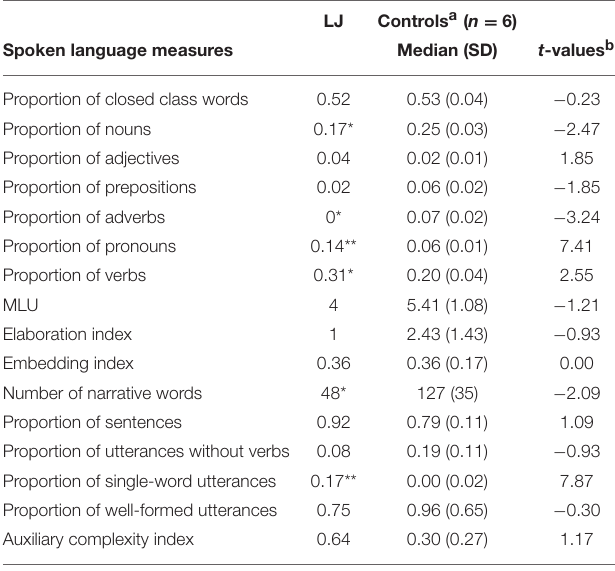
TABLE 4 | LJ’s scores, control group median and standard deviation values and Crawford- t